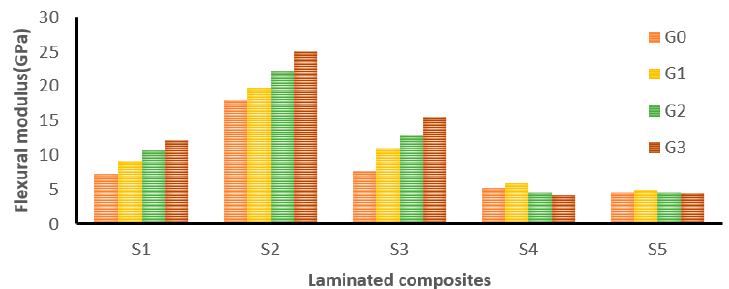
Figure 8. The effect of GNP on the flexural modulus of laminated composites. Figure 8. The e ff ect of GNP on the flexural modulus of laminated composites.